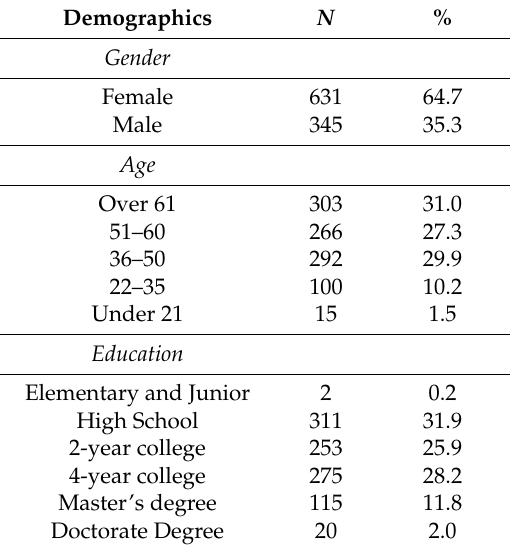
Table 1. Demographic Characteristics of Respondents ( N =